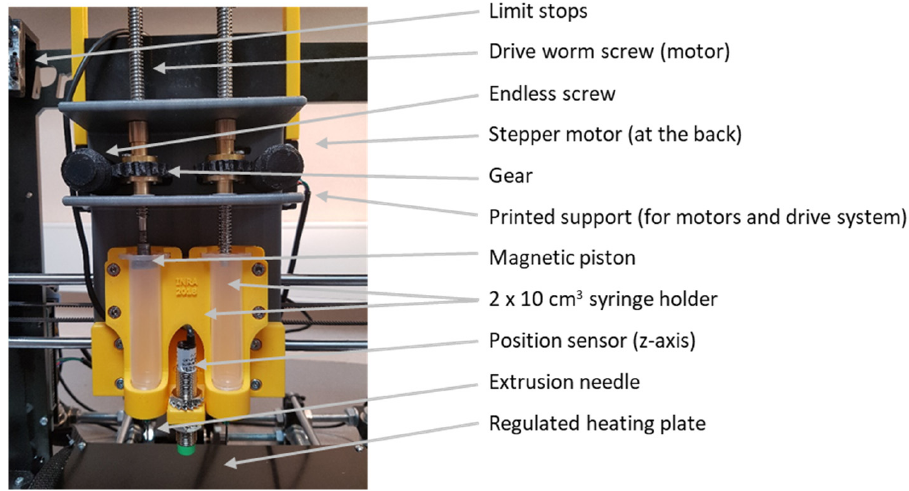
Figure 1. Printhead developed based on a Prusa i3 3D printer. The different modified elements were designed with Inventor ®® and then 3D-printed. Table 2. Main advantages and disadvantages of the first printhead prototype developed from the Prusa i3 3D printer. 1 Original parts of the 3D printer and, 2 Modified devices for the present study.